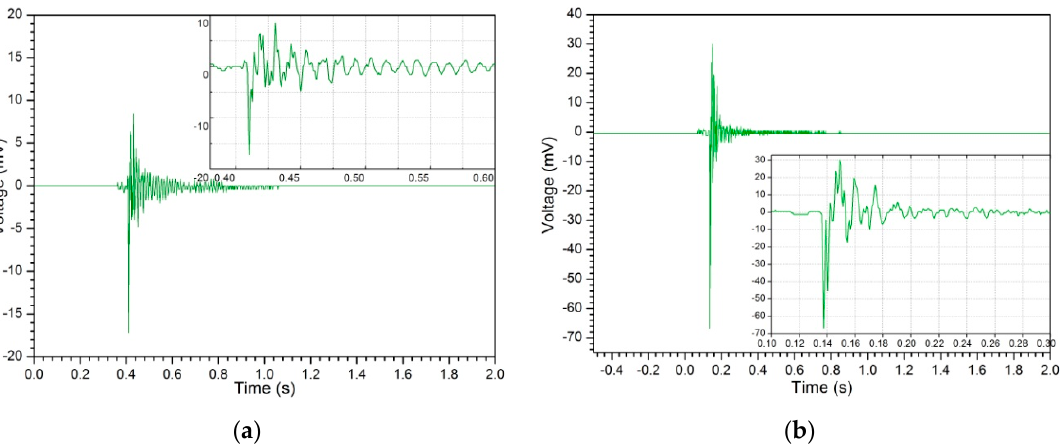
Figure 13. Voltage time-response at transient free vibration (0.010 Kg or0.050 Kg mass): ( a ) initial excitation is 0.098 N (0.010 Kg mass); ( b ) initial excitation is 0.49 N (0.050 Kg mass). Table 2. Energy harvesting and conversion efficiency.